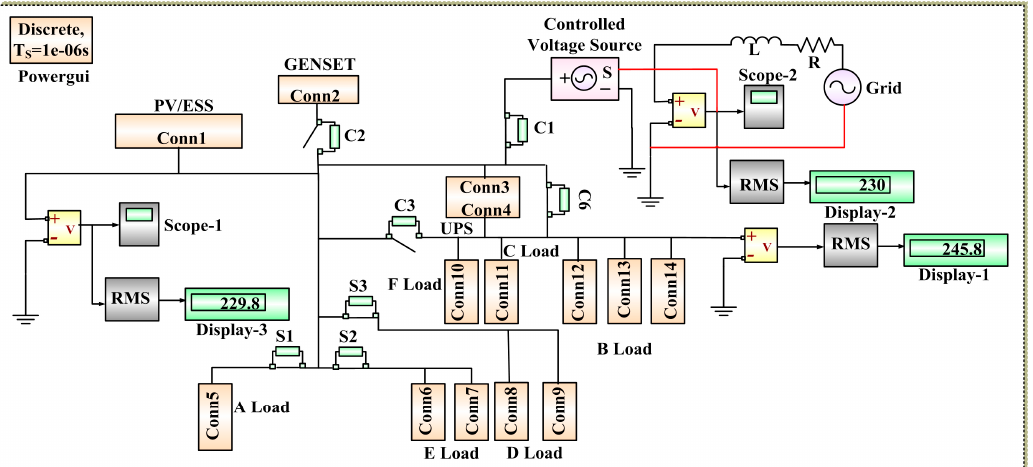
Figure 7. Output voltage of (top to bottom: grid, PV, UPS, and ESS).